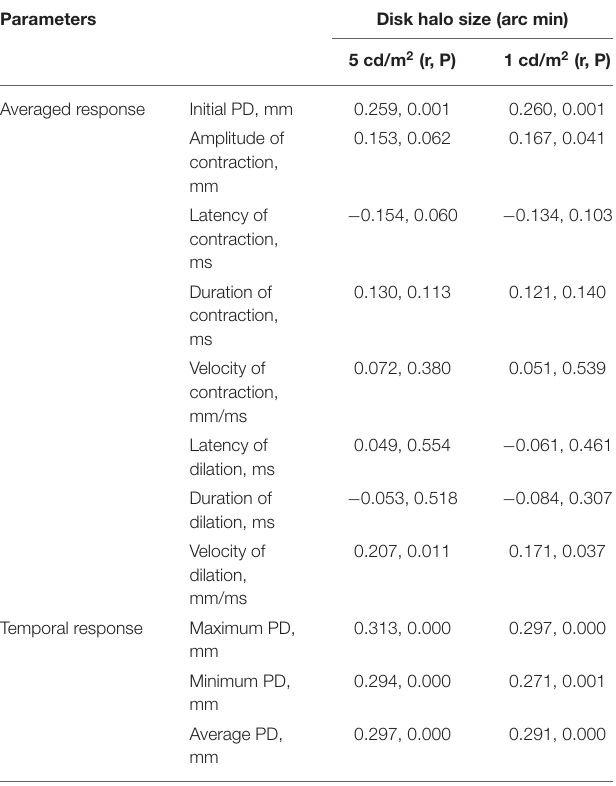
TABLE 4 | Correlations between halo radius and dynamic pupillometry in the study population ( n = 150).